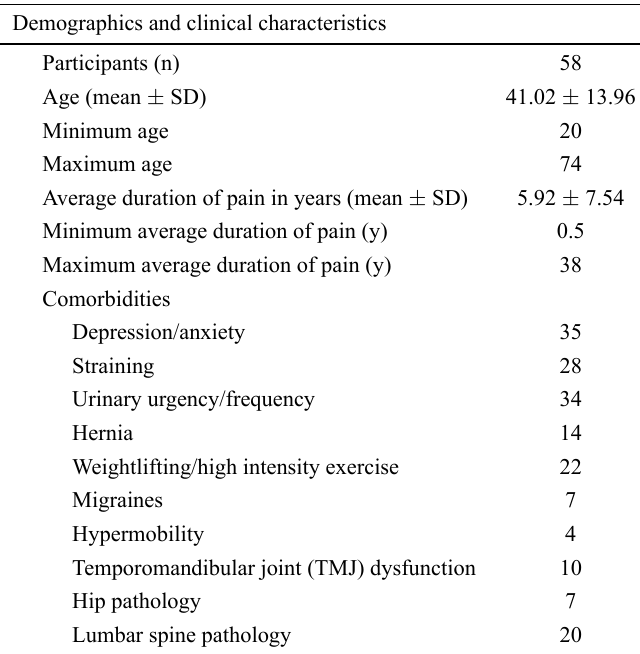
Table 1. Demographics, pain duration, and comorbidities for 58 UCPPS